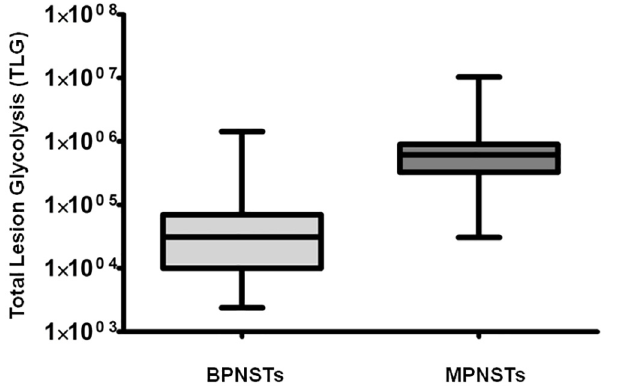
Fig 3. Comparison between TLG of BPNSTs and MPNSTs on a per-lesion basis (SUV max threshold 2.0). TLG is significantly higher in MPNSTs ( p < 0.0001).